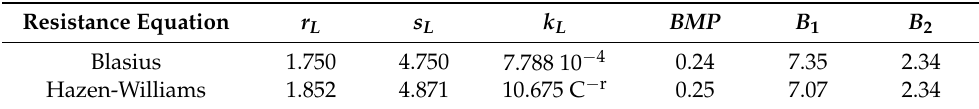
Table 2. Resistance equation parameters of the laterals ( r L , s L , k L ), best manifold position ( BMP ), and calibration constants ( B 1 , B 2 ), for Blasius and Hazen-Williams formula. Rearranged with permission from ref. [29], Copyright 2020, Elsevier (Amsterdam, The Nether-lands). Resistance Equation r L s L k L BMP B 1 B 2 Blasius 1.750 4.750